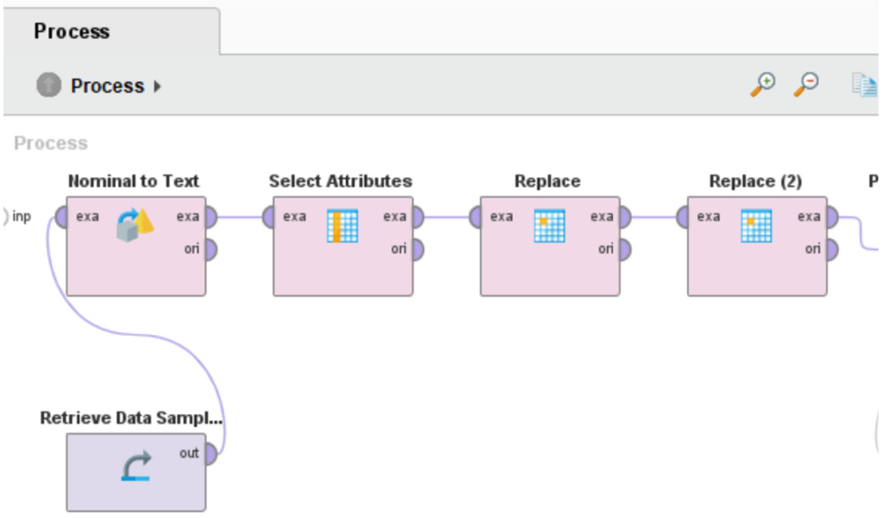
Figure 3. Data collection workflow.